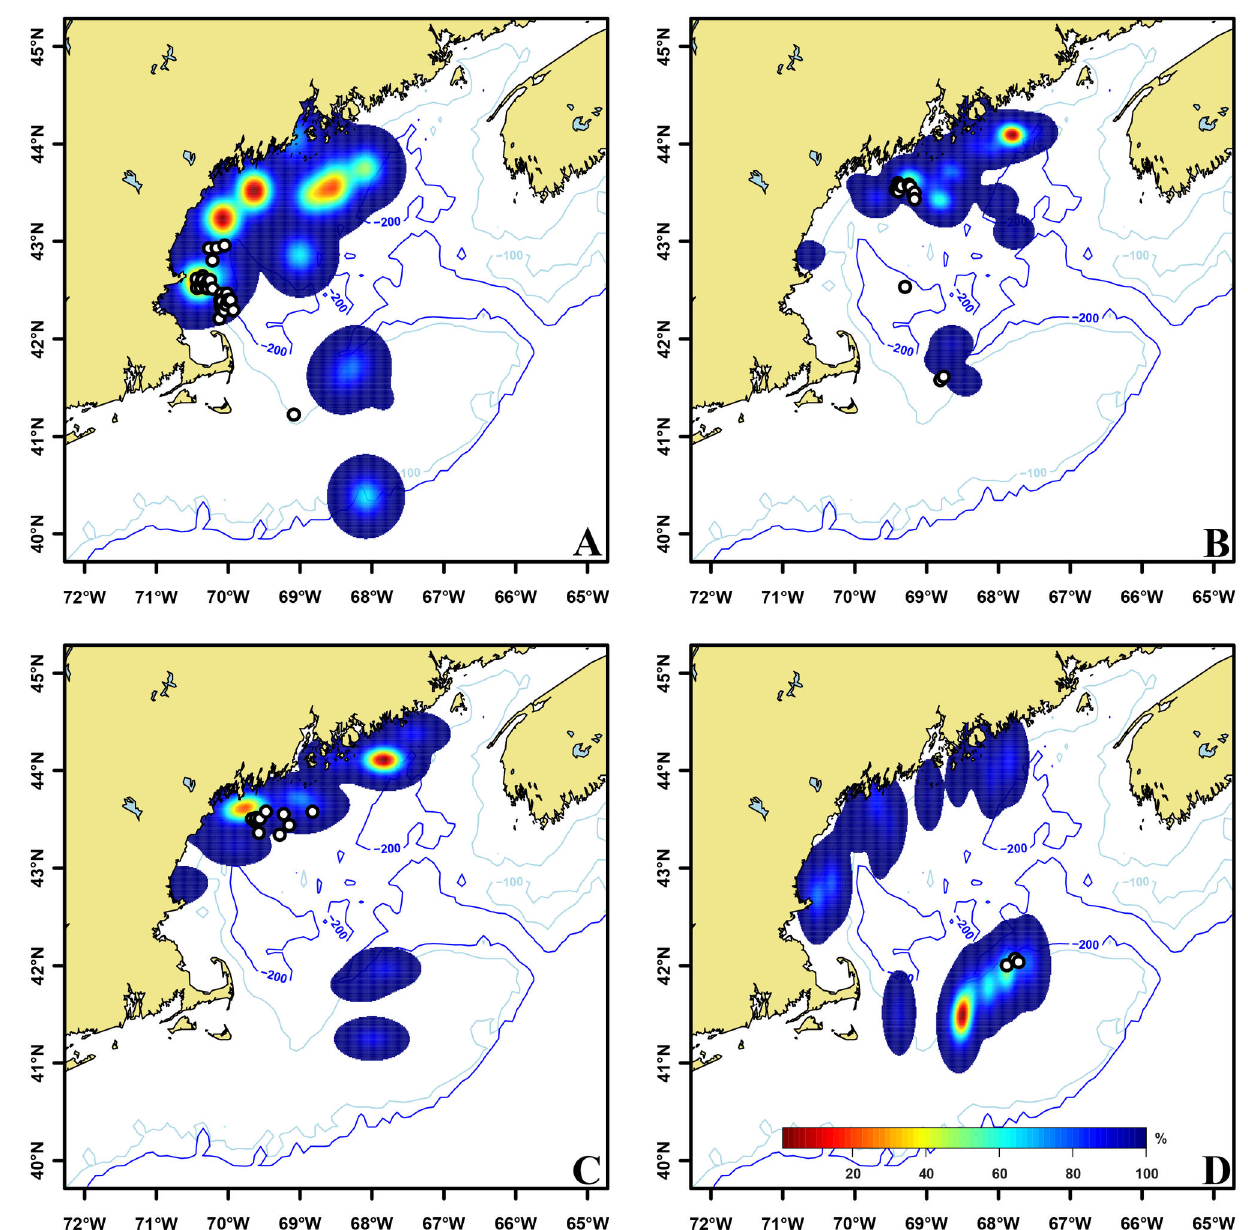
Figure 4. Spatial relationship between Atlantic herring and Atlantic bluefin tuna in the Gulf of Maine. Atlantic herring kernel density estimations were constructed based on the metric tons of herring captured in each tow or set (trawler or purse seiner, respectively). Density estimations were normalized yielding utilization distributions that displayed probability of occurrence during four two week time periods, A) June 1-15 1997, B) August 16-30 2003, C) July 16-31 2004, and August 1-15 2005. Atlantic bluefin tuna (white circles with solid black borders) were located closer to high probability regions of Atlantic herring than a randomly distributed population. While the majority of bluefin tuna schools were located within areas of high herring probability, some schools of bluefin tuna did not display any association with herring.